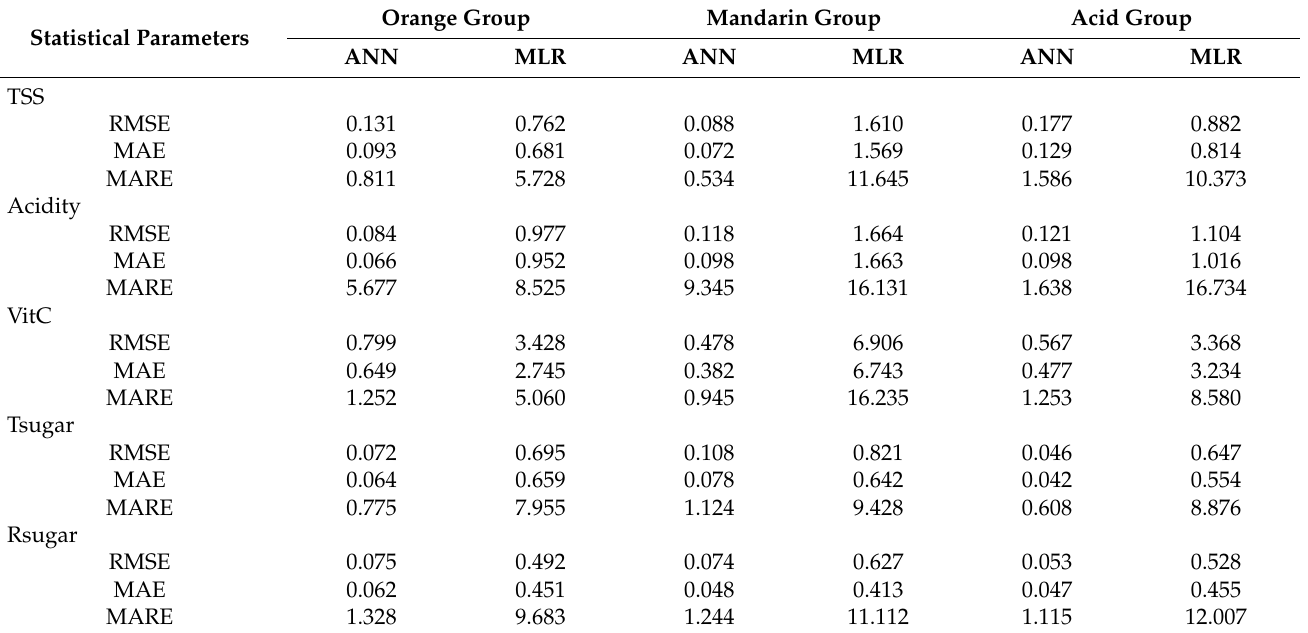
Table 10. Total soluble solids (TSS), acidity, vitamin C (VitC), total sugars (Tsugar), and reducing sugars (Rsugar) of the fresh fruits for three citrus groups with the developed ANN and MLR models for the validation